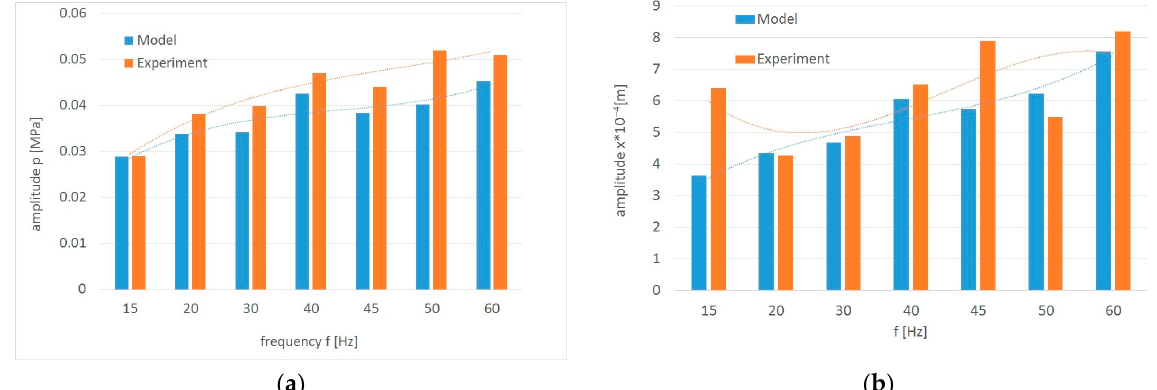
Figure 8. Comparison of the amplitudes of the harmonic component of the amplitude-frequency spectrum: ( a ) pressure pulsation resulting from external mechanical vibrations; ( b ) the spool vibrations resulting from external mechanical vibrations.